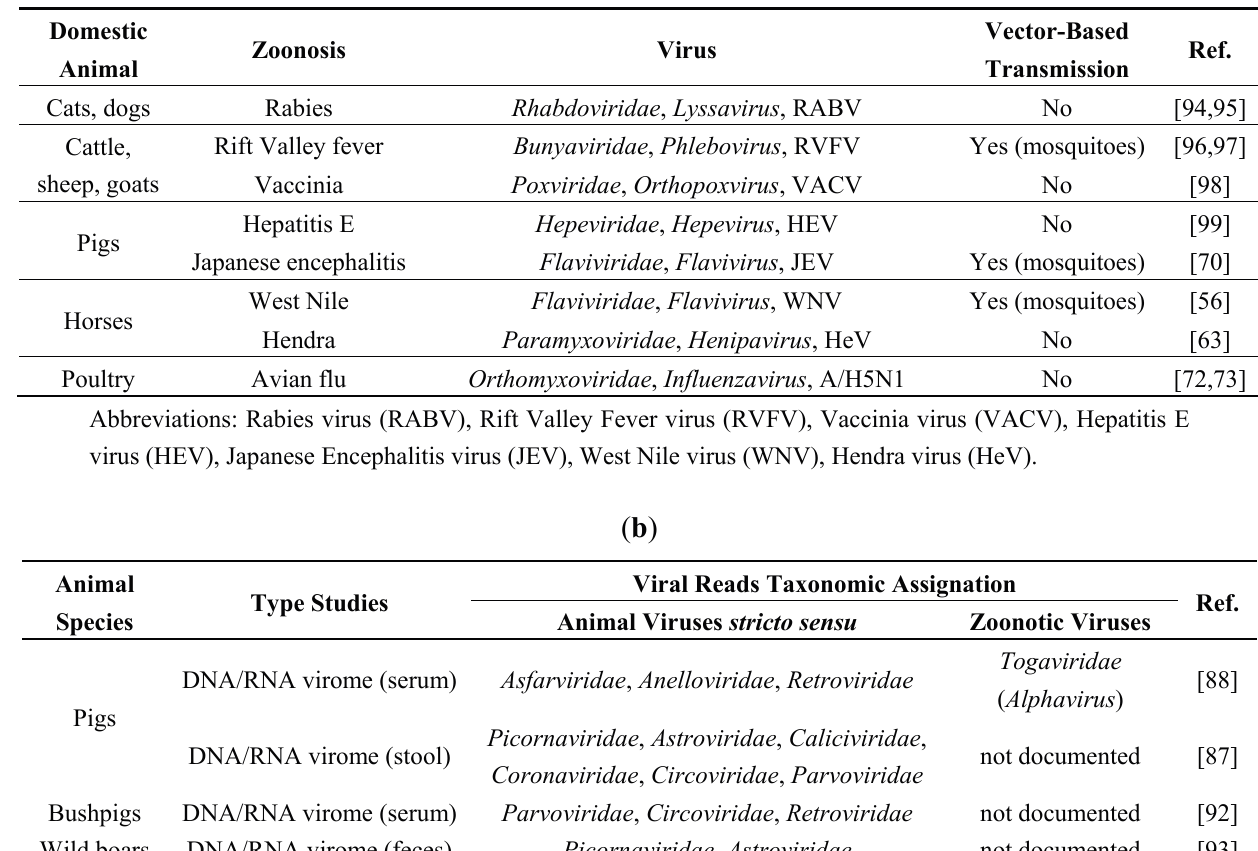
Table 3. ( a ) Non-exhaustive list of major zoonotic viruses detected in domestic animals; ( b ) Examples of viruses detected in suid species by metagenomic diversity studies. ( a ) Vector-Based Domestic Zoonosis Virus Transmission